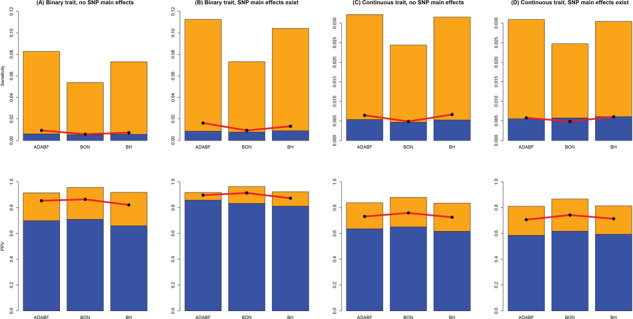
Sensitivity and PPV The sensitivity (the top row) is defined as the total number of true findings over the total number of SNP × E in the 1000 simulation replications, i.e. 20 000 or 50 000 (recall D = 20 or 50 in Equations 13–16). PPV (the bottom row) is defined as the total number of true findings over the total number of findings in the 1000 simulation replications. BON is single marker analysis while controlling the FWER at 5% using the BON; BH is single marker analysis while controlling the FDR at 5% using the BH. The height of the blue (yellow) bars marks the sensitivity/PPV of each method given 20 SNP × E with smaller (larger) effect sizes. The red line with black points marks the sensitivity/PPV given 50 SNP × E with smaller effect sizes.